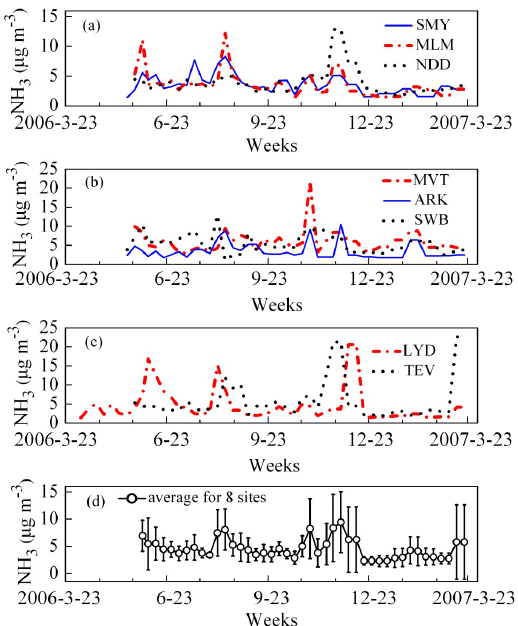
Fig. 2. Temporal variations of NH 3 in 2006–2007 at high concen- tration zone sites: (a) three sites having no spike in winter, (b) three sites having a spike in winter, (c) two sites having data before June, and (d) the spatially averaged value over eight sites.